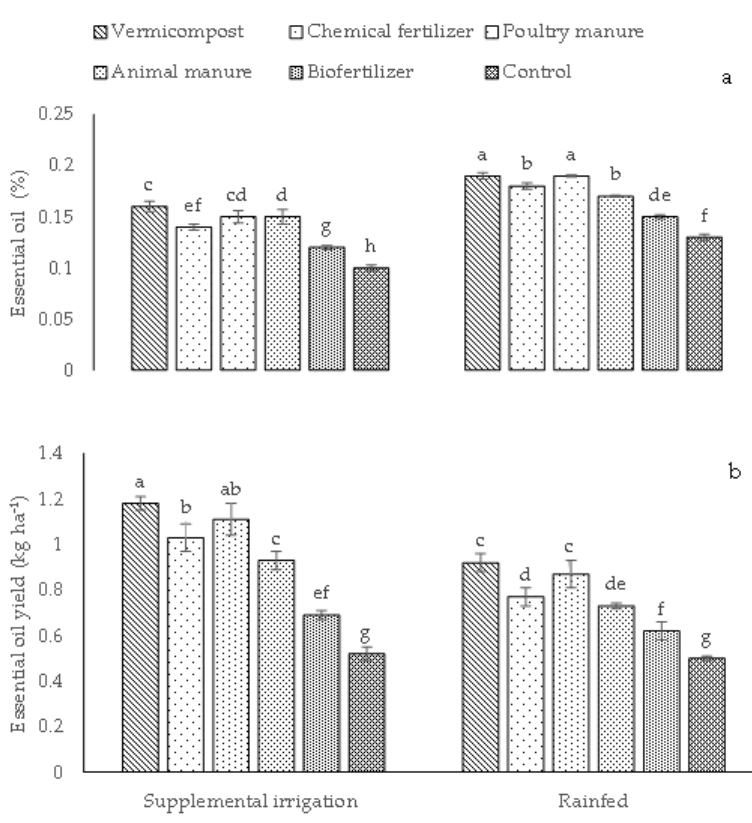
Figure 9. Means ( ± Standard deviation, SD) comparison for the interaction impacts of fertilizer and irrigation conditions on essential oil ( a ) and essential oil yield ( b ). The means with different letters differ significantly at p ≤ 0.05 based on Tukey’s HSD